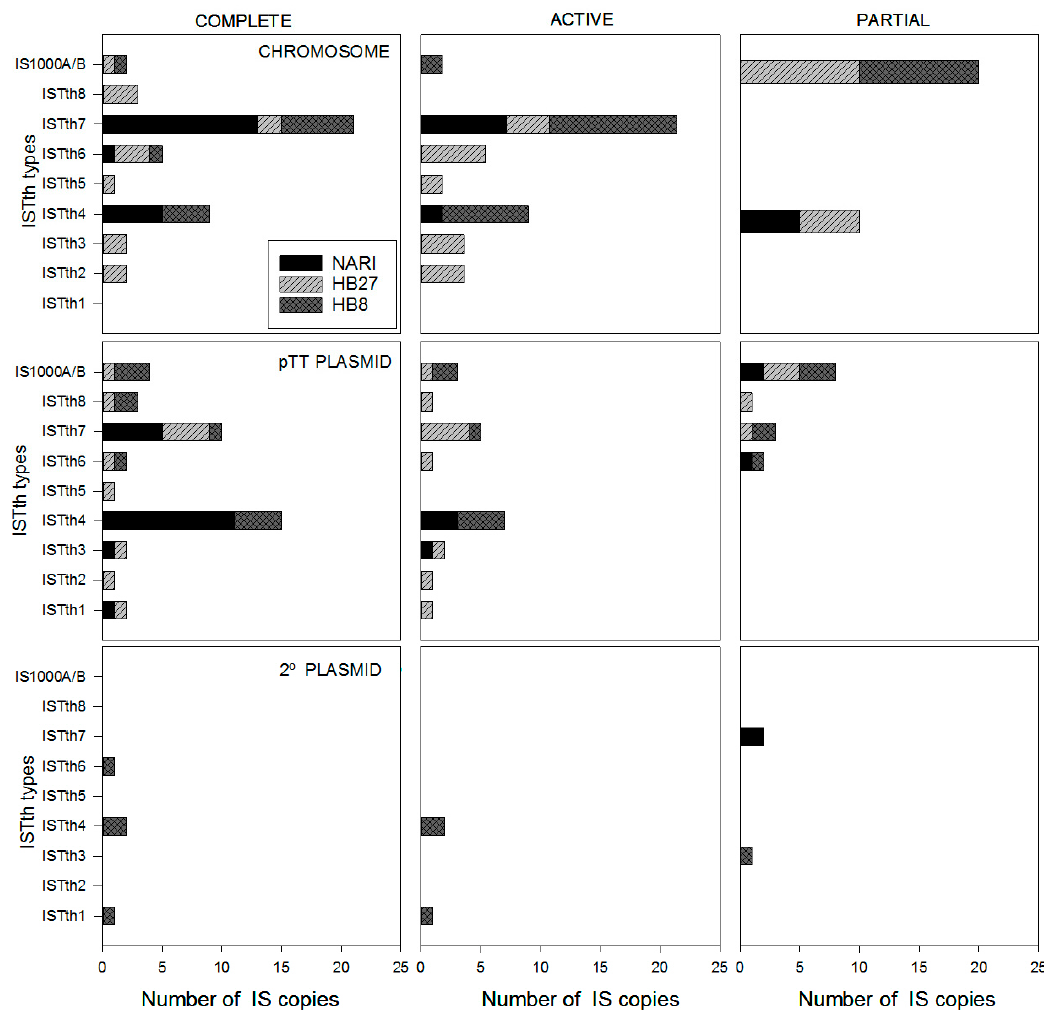
Figure 2. Abundance of insertion sequences across Thermus thermophilus . Number of full copies (complete), potentially active (middle column), and incomplete (partial) IS sequences found in the genomes of T. thermophilus HB27, HB8, and NARI strains. Sequences were localized to the chromosome (first row), pTT27 (HB27 and HB8), and M1 (pTT PLASMID; NAR1) megaplasmids (middle row), or in pVV8 (HB8) and M2 megaplasmid (NAR1) (2º PLASMID, third row).